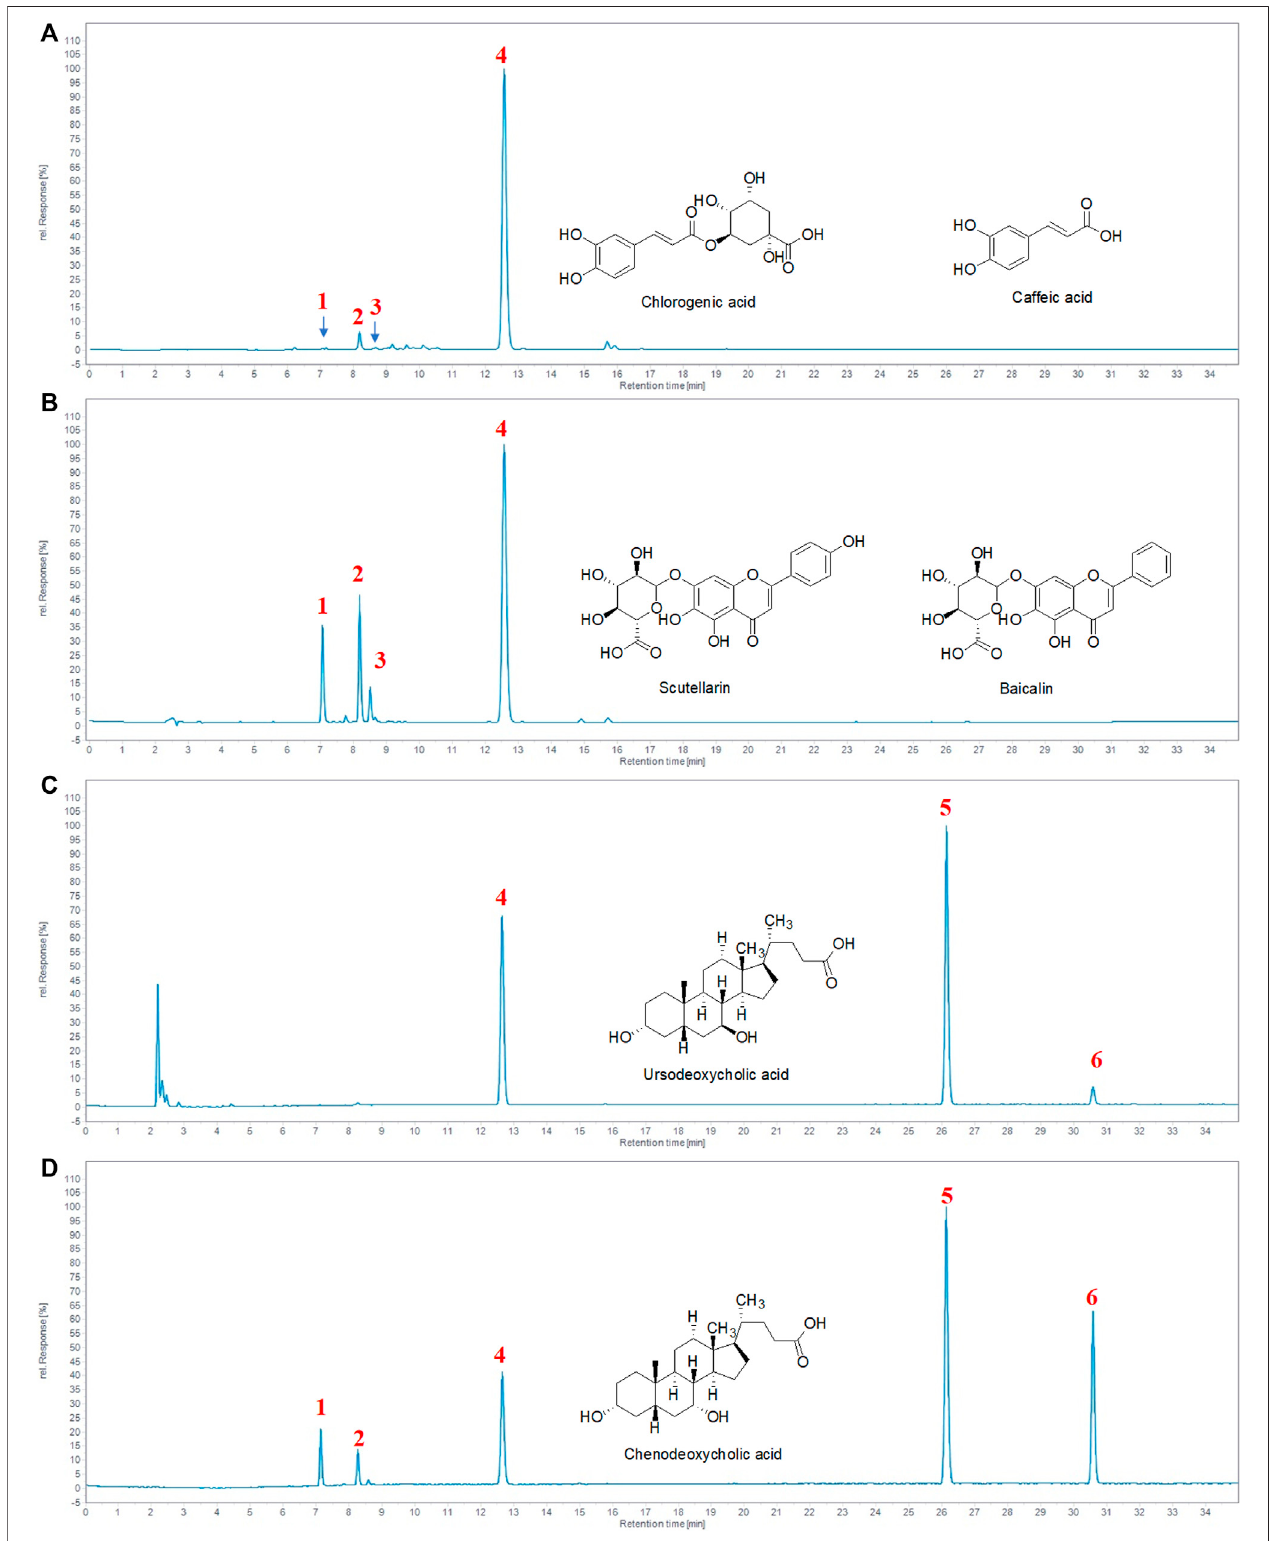
FIGURE 1 | Identi fi cation ofthe major chemical componentsof TRQ. (A – B) The UV chromatogram of TRQ and mixed standards. (C – D) The ELSD chromatogram of TRQ and mixed standards. The numbers 1, 2, 3, 4, 5, and 6, respectively, represent chlorogenic acid, caffeic acid, scutellarin, baicalin, ursodeoxycholic acid, and chenodeoxycholic acid.